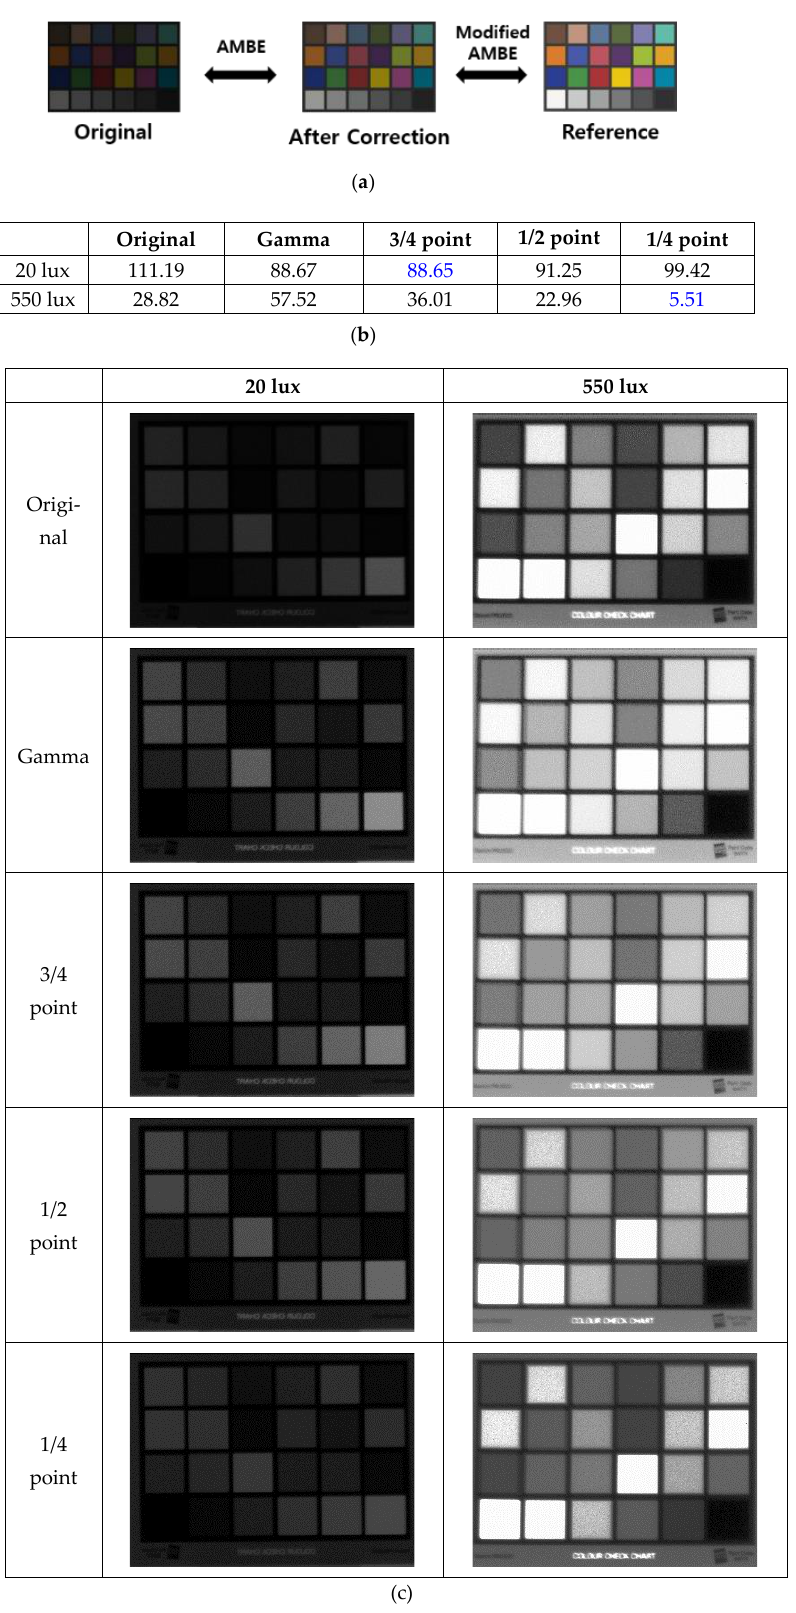
Figure 8. ( a ) AMBE and M-AMBE concepts; ( b ) calculated M-AMBE; and ( c ) captured